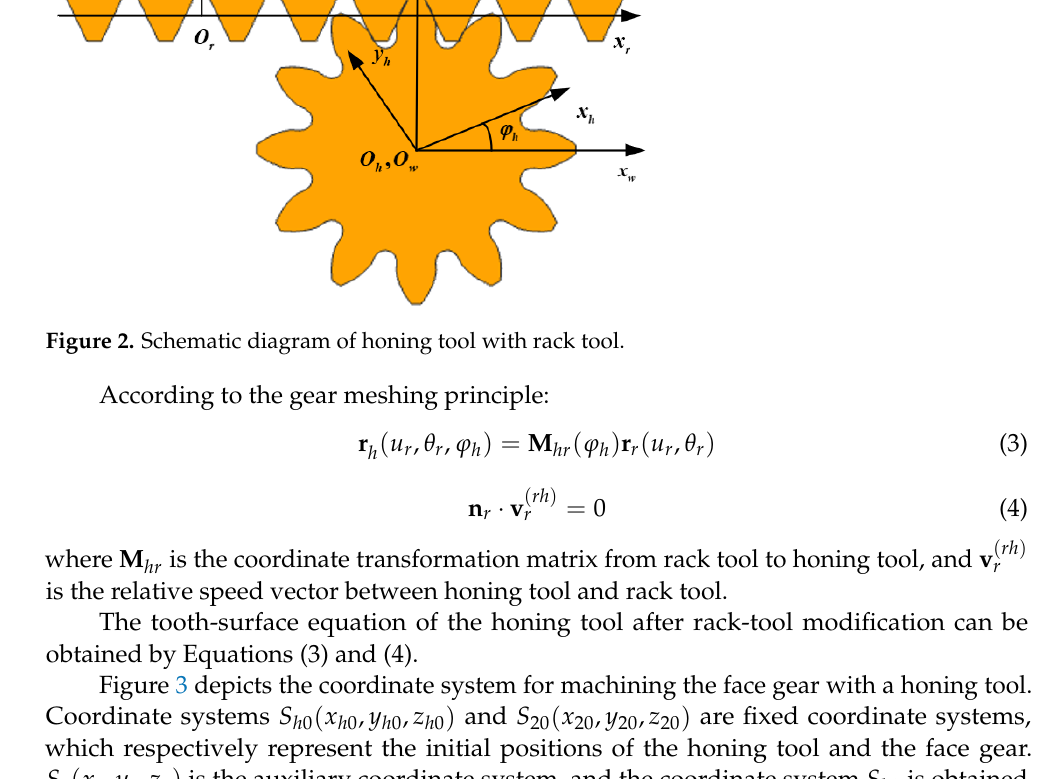
by its rotation angle λ 0 around the x a axis. S h ( x h , y h , z h ) is the moving coordinate